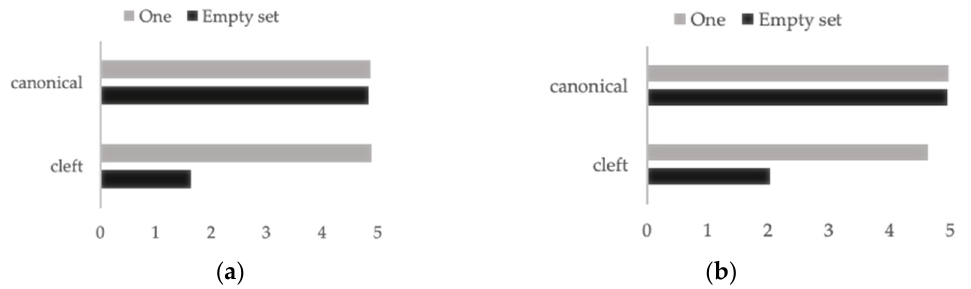
Figure 1. Ratings for clefted and canonical questions per answer type; ( a ) French natives ; ( b ) L2